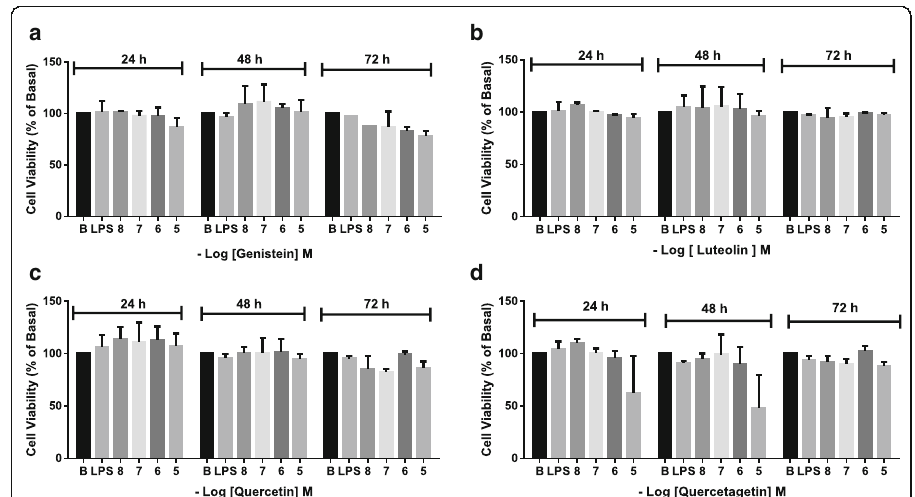
Fig. 2 Flavonoid effect on cell viability. Cell viability in the presence of genistein ( a ), luteolin ( b ), quercetin ( c ) and quercetagetin ( d ) was evaluated using the MTT assay. H9c2 cells were treated with flavonoid (10 nM − 10 μ M) for 24, 48 and 72 h. Quercetagetin reduced cell viability at the highest concentration at 24 and 48 h without significant difference. No other flavonoid modified cell viability. The results are expressed as means ± SEM from at least three independent